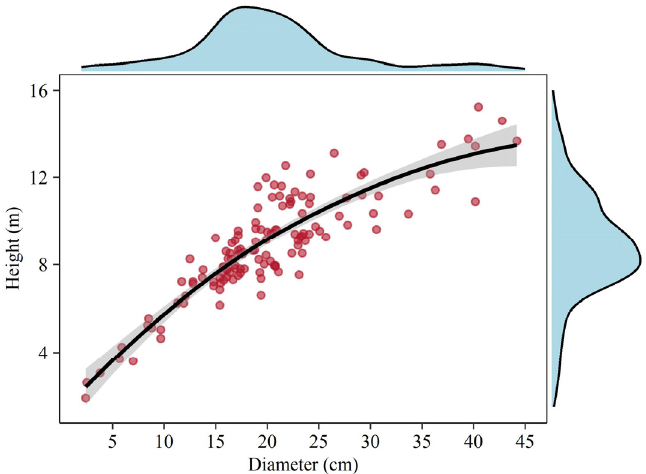
Figure 2. Correlation between tree height and diameter for sampled trees. The density diagrams on the top and right side indicate the distribution of diameter and height, respectively. The solid line indicates loess smoothing with a 95% confidence interval.